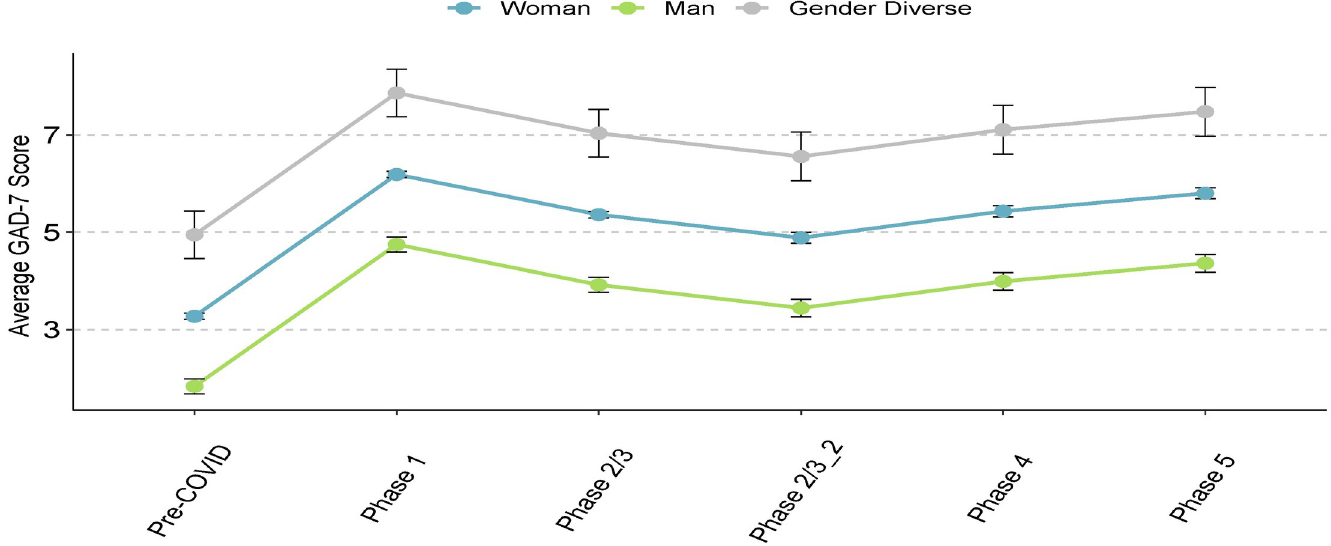
Fig 3. Anxiety symptoms, as measured by the GAD-7, across phases of the pandemic. Data points refer to mean scores of the given psychosocial measure, error bars refer to the standard error. Pre-COVID: Prior to mid-March 2020; Phase 1: Mid-March 2020 to mid-May 2020; Phase: 2/3: Mid-May 2020 to November 2020; Phase